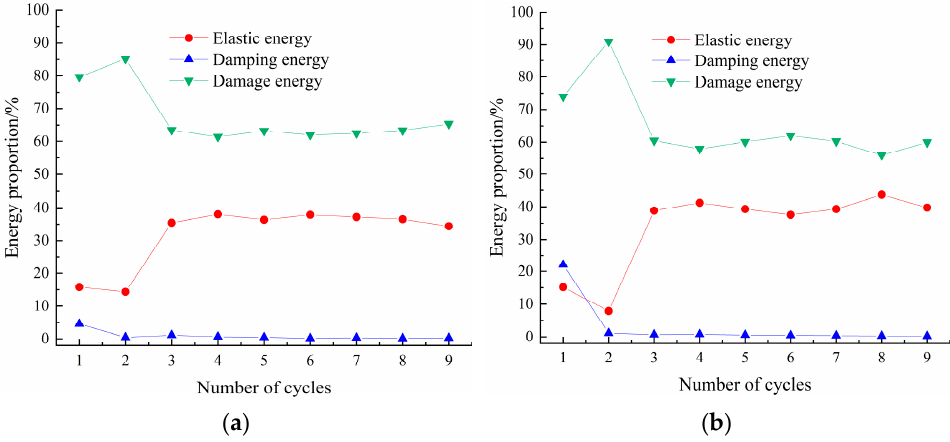
Figure 16. The evolution of rock energy proportion under VLLCL. ( a ) Sandstone; ( b ) granite.